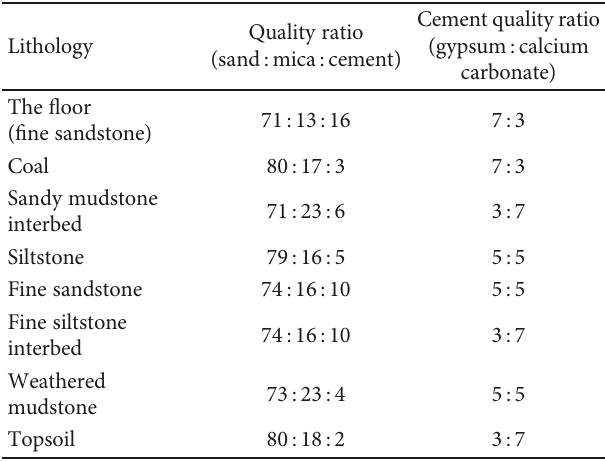
Table 1: Strata simulation material ratio scheme in the physical model.